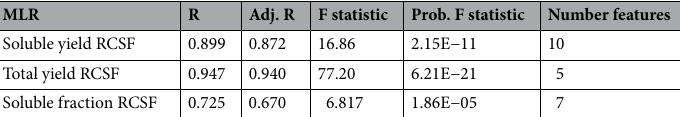
Table 2. Summary statistics of RCSF multiple linear regressions.